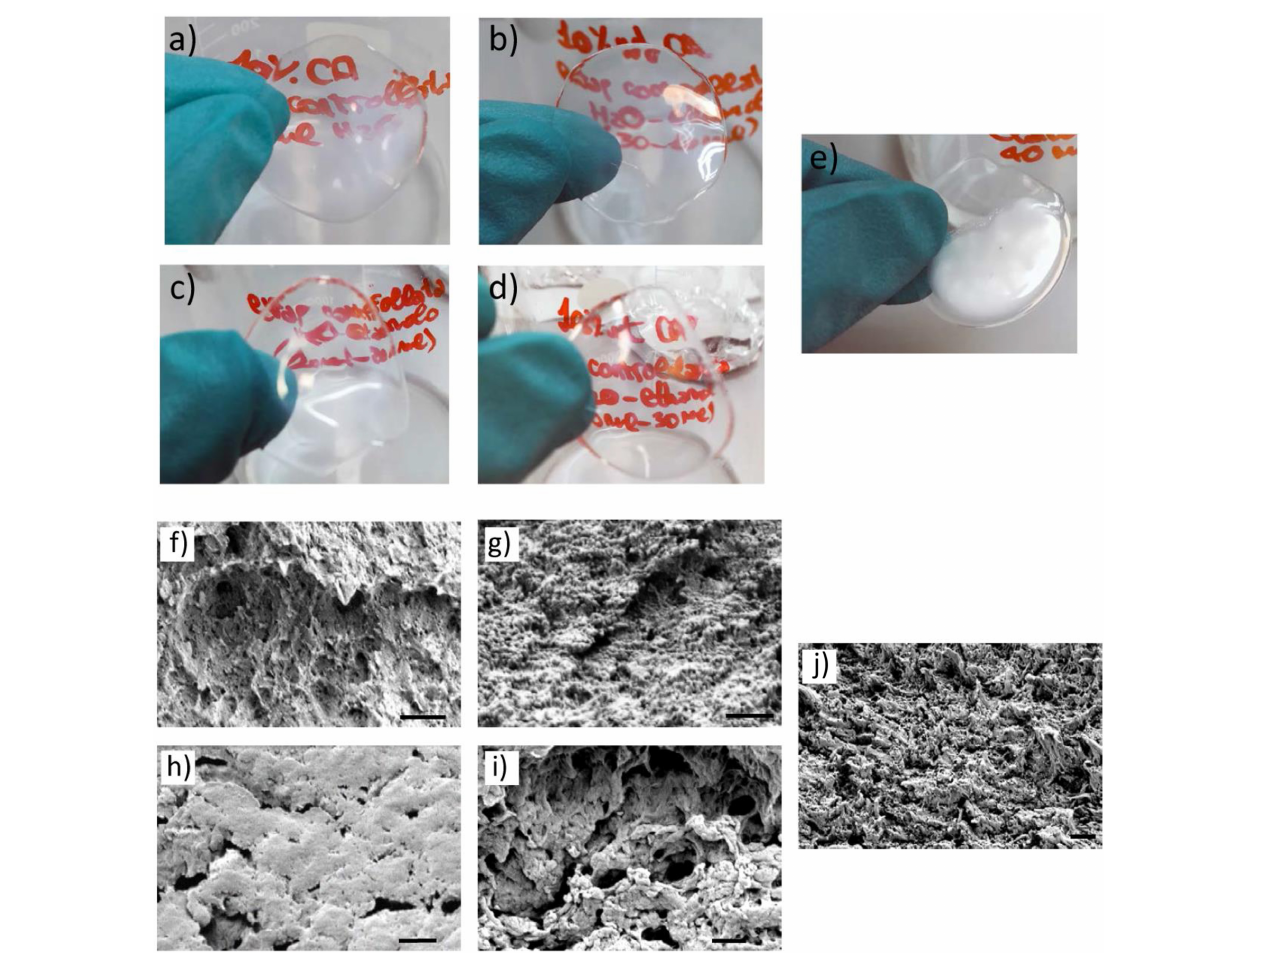
FIGURE 1 | CA membranes (from 10.0% wt CA solutions) prepared via VIPS. (A–E) Photographs and (F–J) SEM images of the transverse section of CA membranes obtained with different non-solvent mixtures: (A,F) 100% H 2 O, (B,G) 75% H 2 O + 25% EtOH, (C,H) 50% H 2 O + 50% EtOH, (D,I) 25% H 2 O + 75% EtOH, and (E–J) 100% EtOH. Scale bar: 1 µ